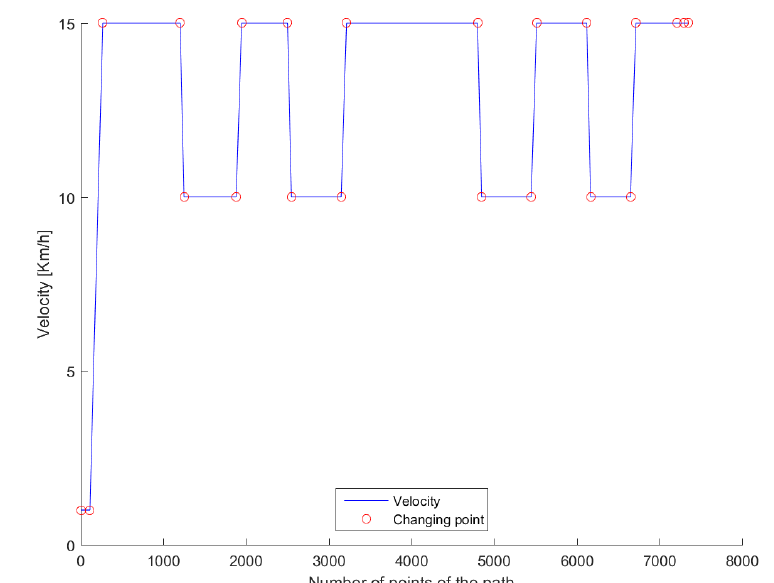
Figure 8. Velocity profile for the test drive.